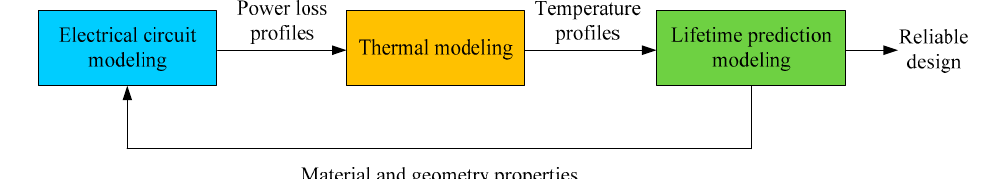
Figure 2. Process of lifetime prediction for the IGBT module.